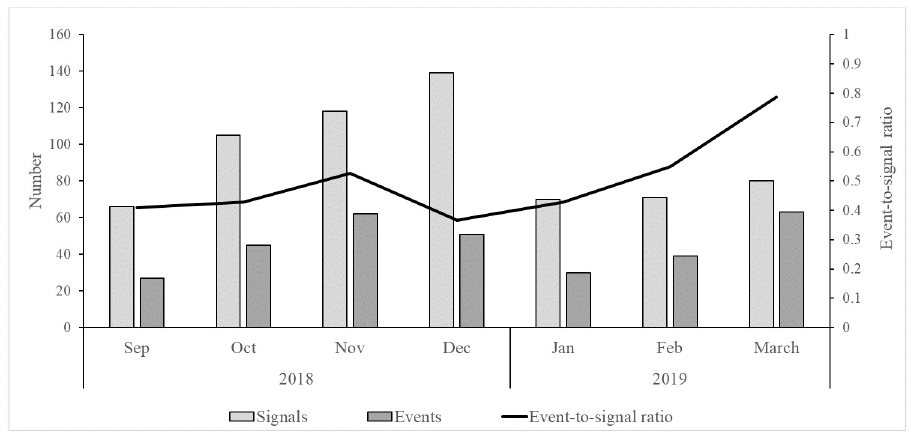
Fig 3. Number of signals and events reported, by month, from Phase II modified CBS districts, September 2018– March